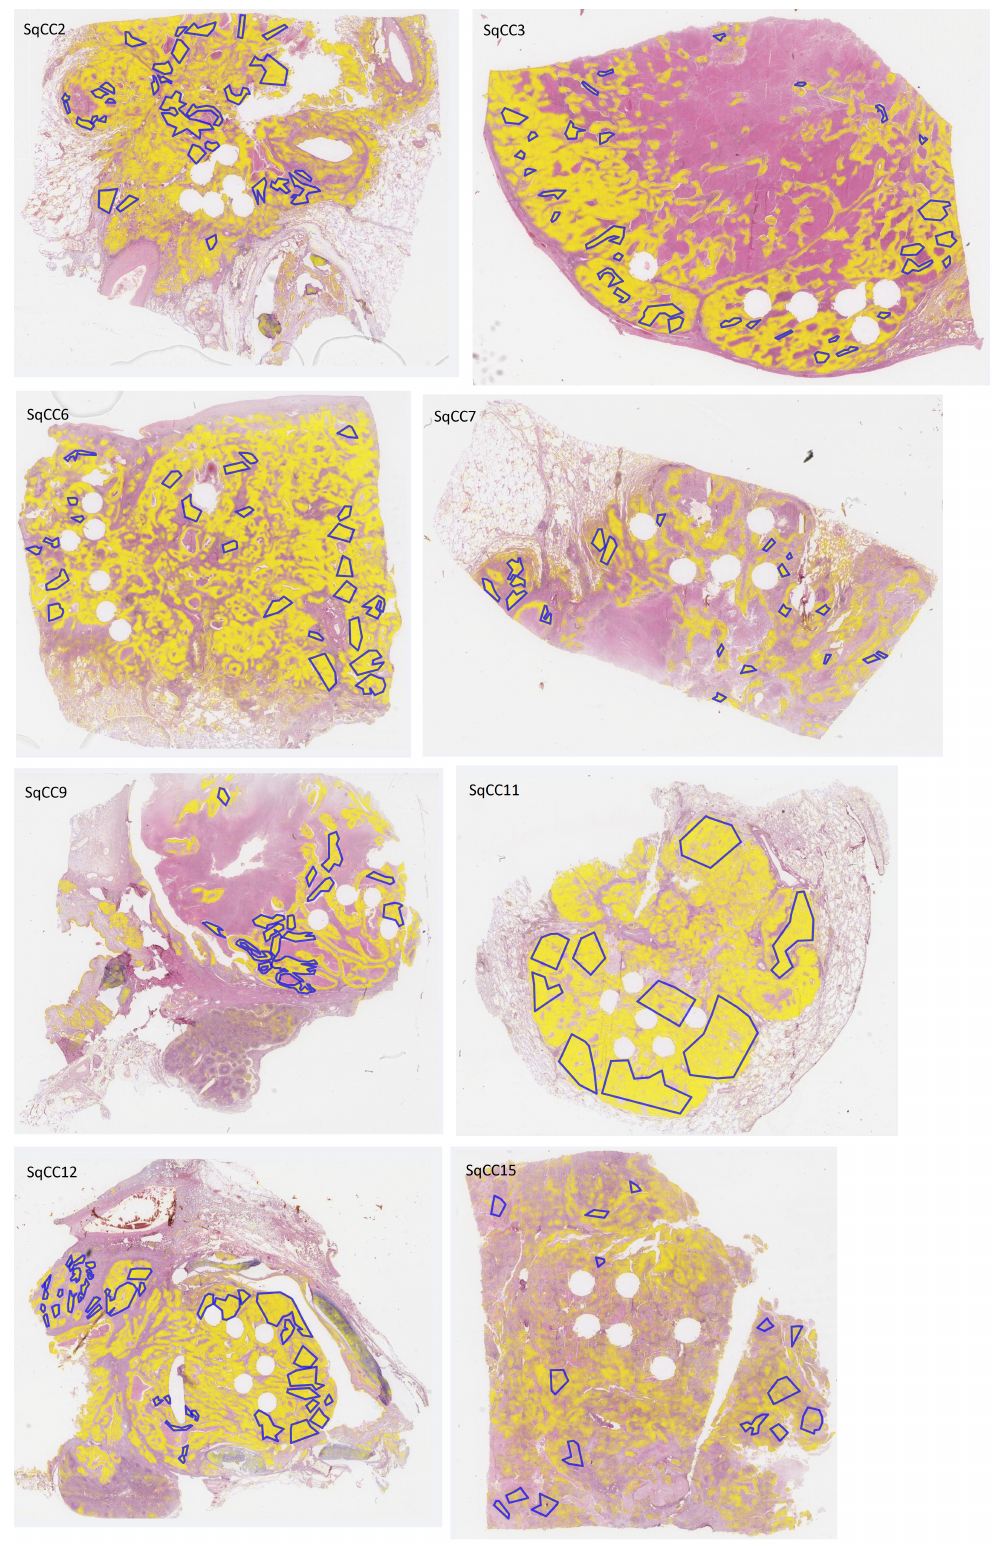
Figure A2. H&E-stained whole-slide images of test sections with overlaid annotations (red lines: ADC, blue lines: SqCC) and heatmaps (yellow filling) of segmented tumor areas based on network Seg1